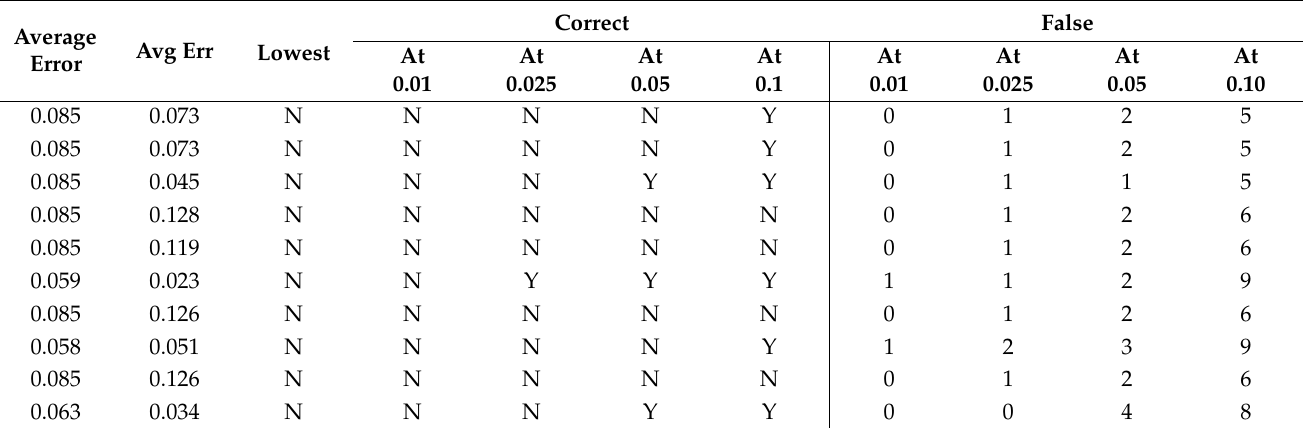
Table A45. Set 1, trials 21–30 summary data (all 0.5 PR values).